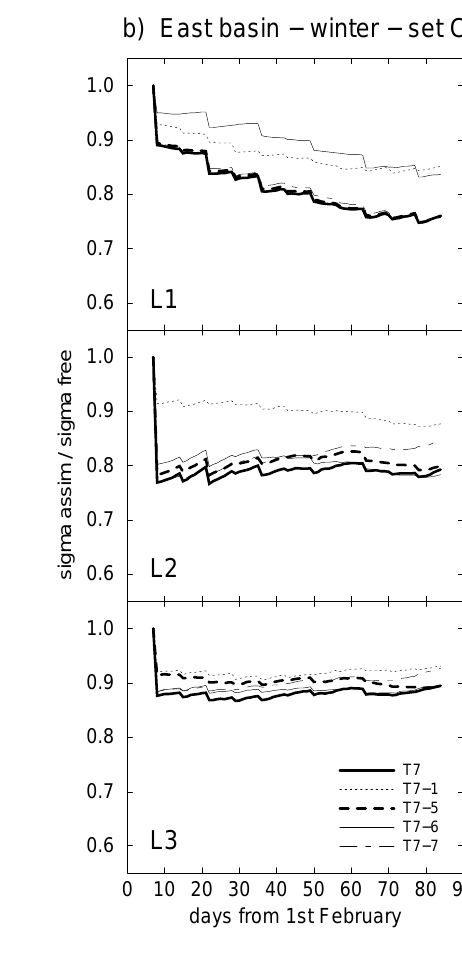
Fig. 8. As Fig. 6 for winter OSSEs.